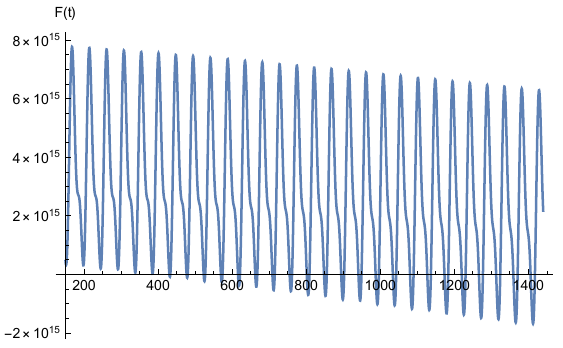
Fig. 6 Visibility Intervals Between HST and ODIN For 24-H with Air Drag Force